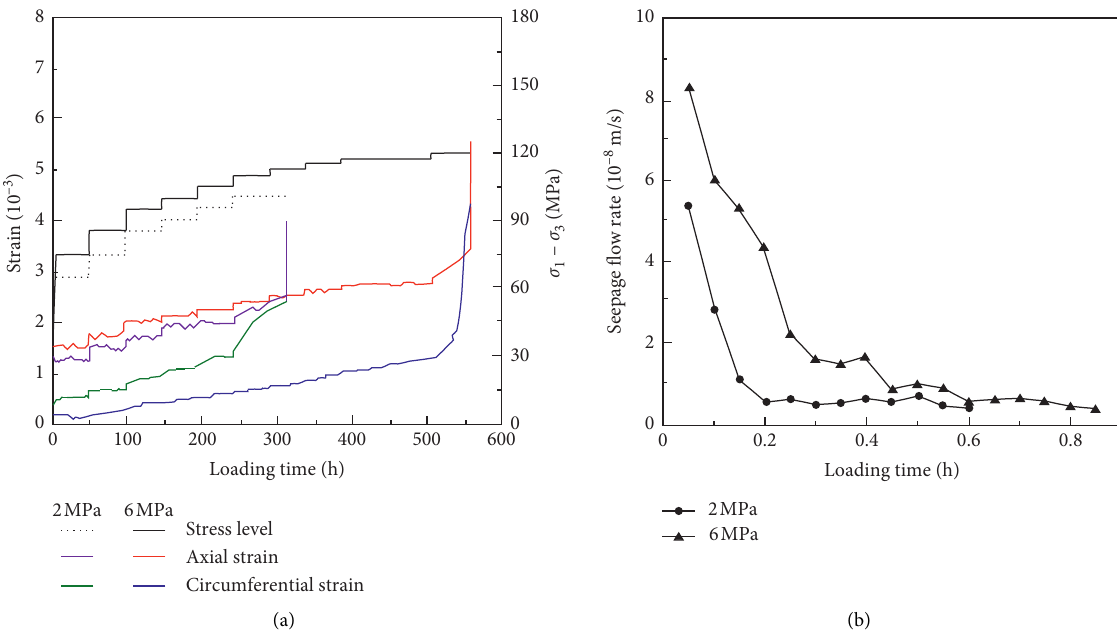
Figure 4: Test results of the granite foundation under different confining pressures. (a) Creep properties for volcanic breccia; (b) seepage flow rate at the instantaneous strain